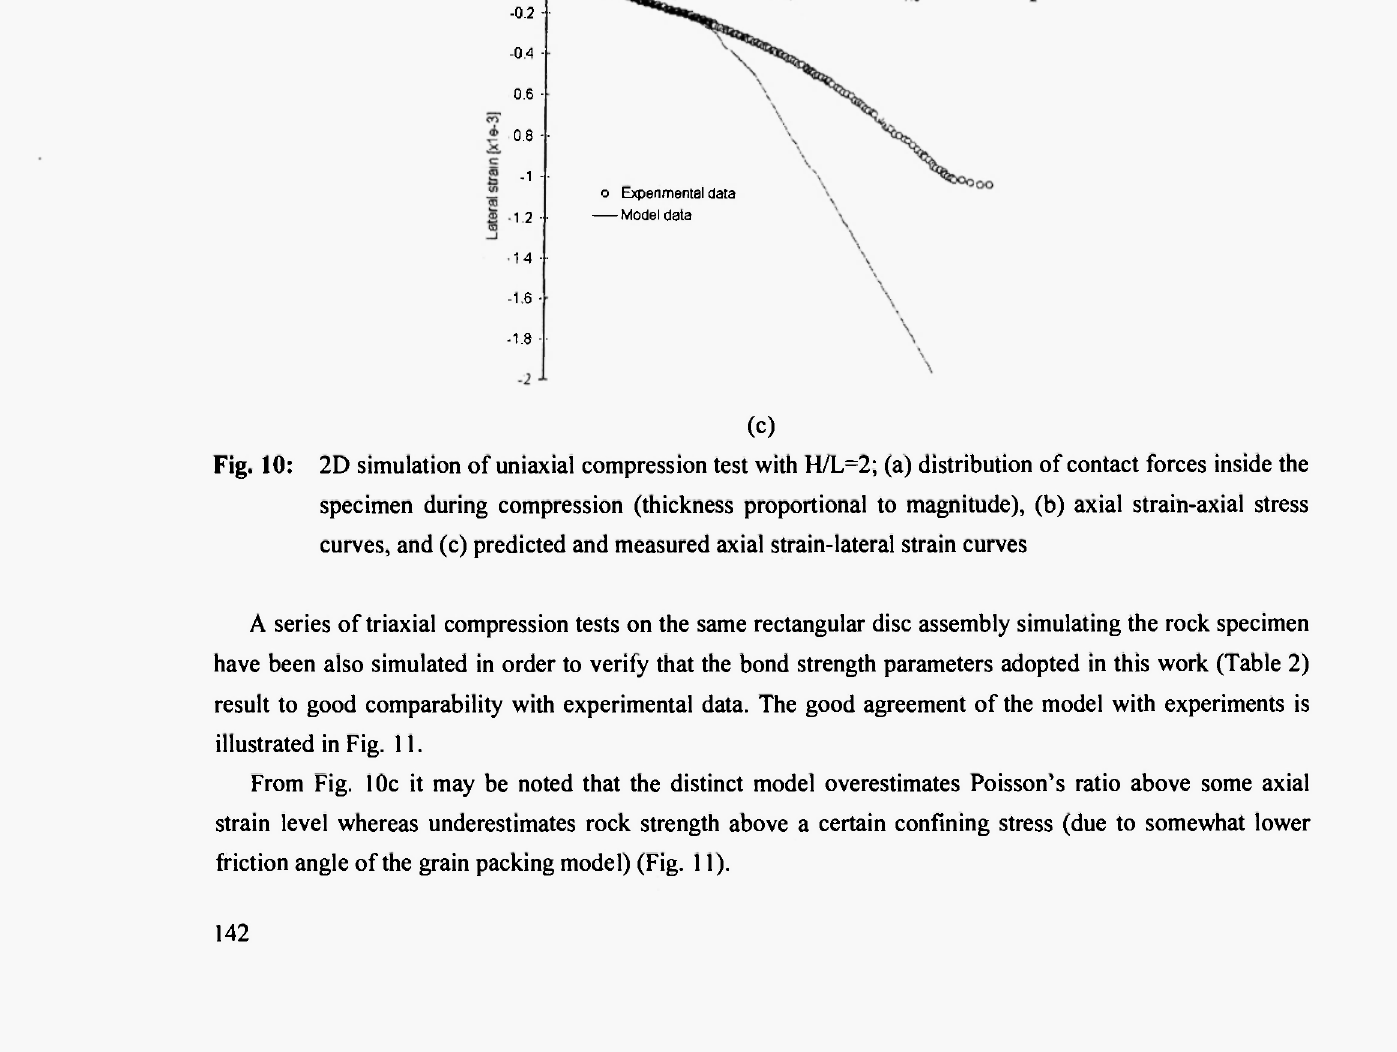
Fig. 10: 2D simulation of uniaxial compression test with H/L=2; (a) distribution of contact forces inside the specimen during compression (thickness proportional to magnitude), (b) axial strain-axial stress curves, and (c) predicted and measured axial strain-lateral strain curves